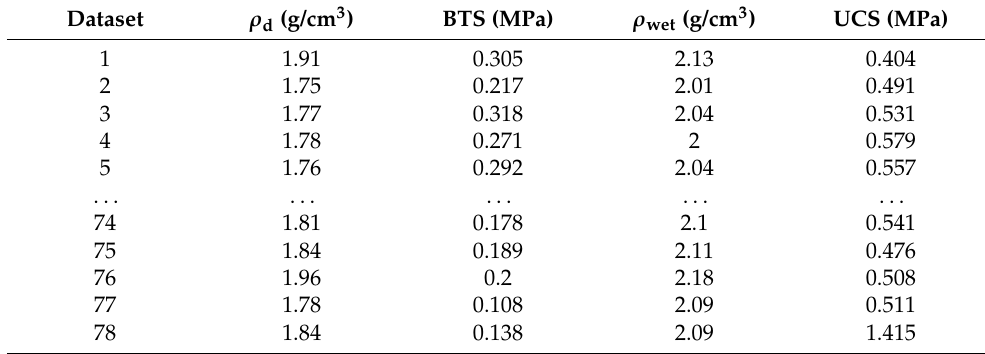
Table 2. Physical and mechanical parameters of the dataset.